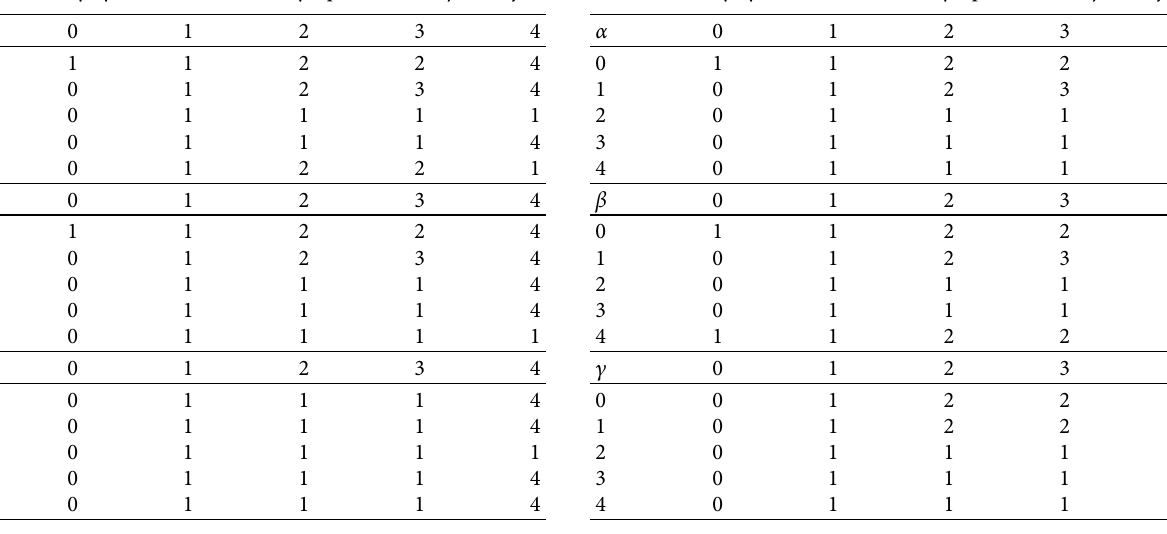
Table 12: Cayley tables for the binary operations “ α , β , and c